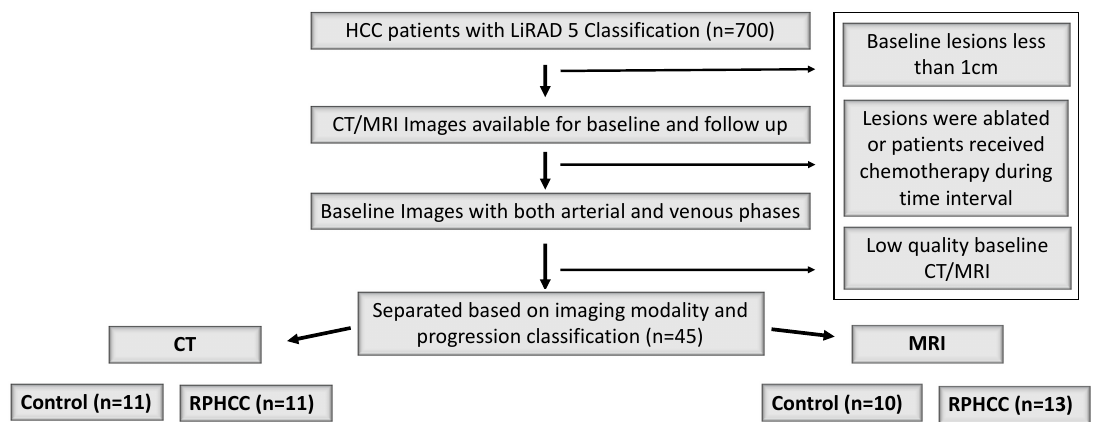
Figure 1. Inclusion/exclusion flowchart of patient selection for rapidly progressive hepatocellular carcinoma (RPHCC) and control tumors in the CT and MRI groups. CT cohort of n = 11 RPHCC and n = 11 non-RPHCC and an MRI cohort of n = 13 RPHCC and n = 10 non-RPHCLC.